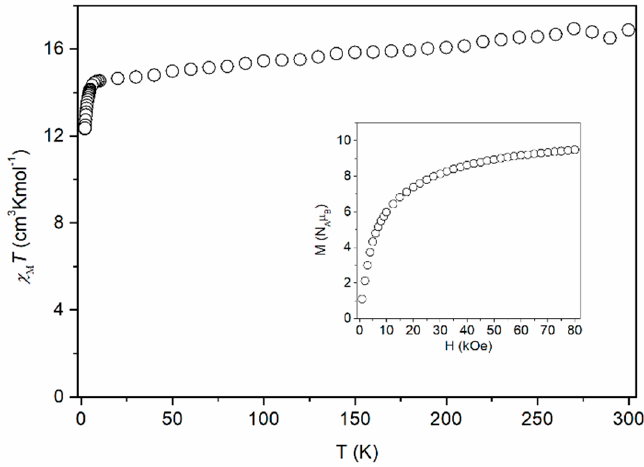
Figure 4. Plots of χ M T vs. T at 1000 Oe and M vs. H at 2 K (inset) for 1